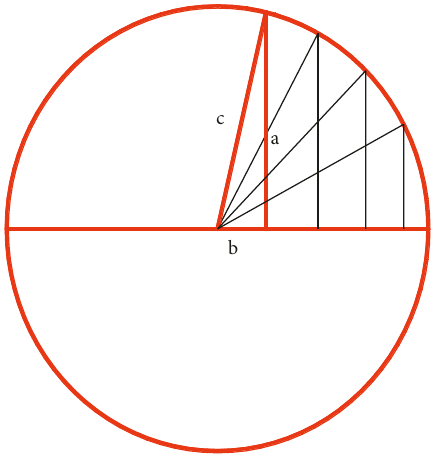
Figure 4: The geometric graph on a circle.